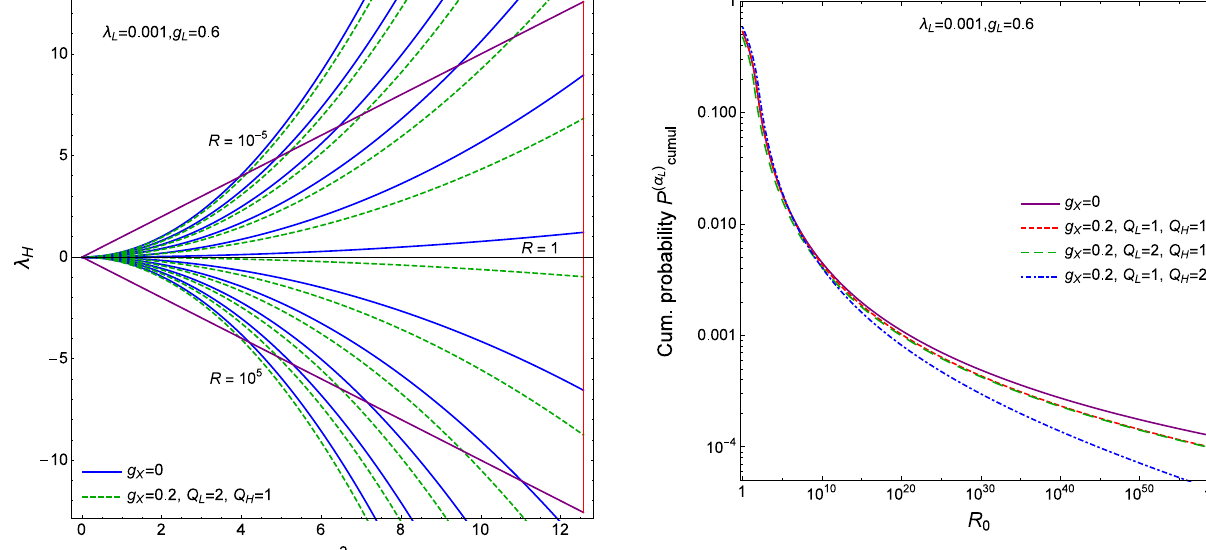
Fig. 2 Comparison of the cumulative probability P (α L ) for fixed cumul λ = 10 − 3 and g = 0 . 6, both for decoupled LH sectors ( g = 0) L L X ,λ ) H H and weakly interacting LH sectors (with g X = 0 . 2 and for different couplings ( Q L , Q H ) for each